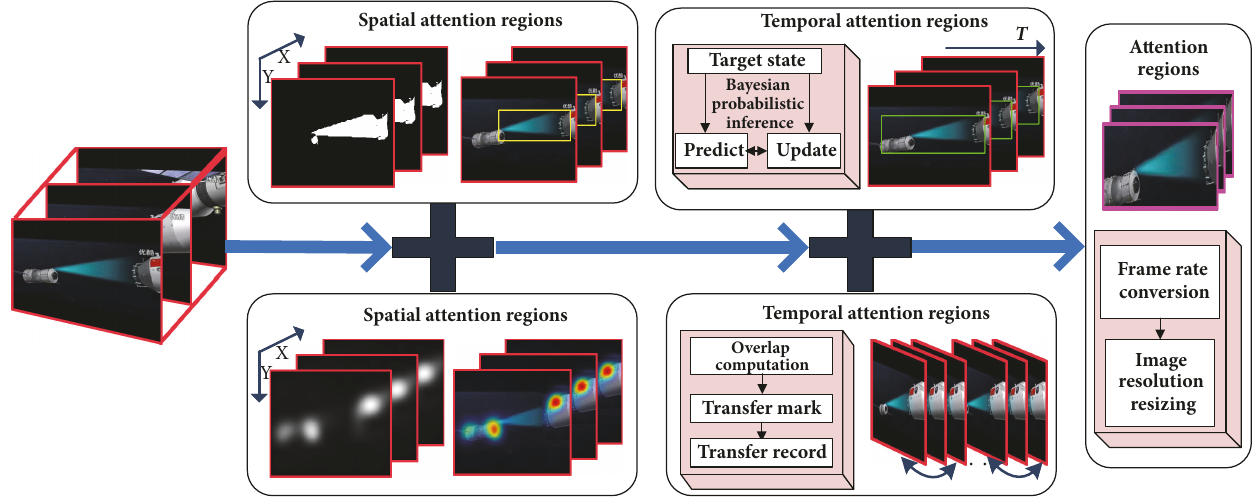
Figure 2: The flowchart of the module of attention region